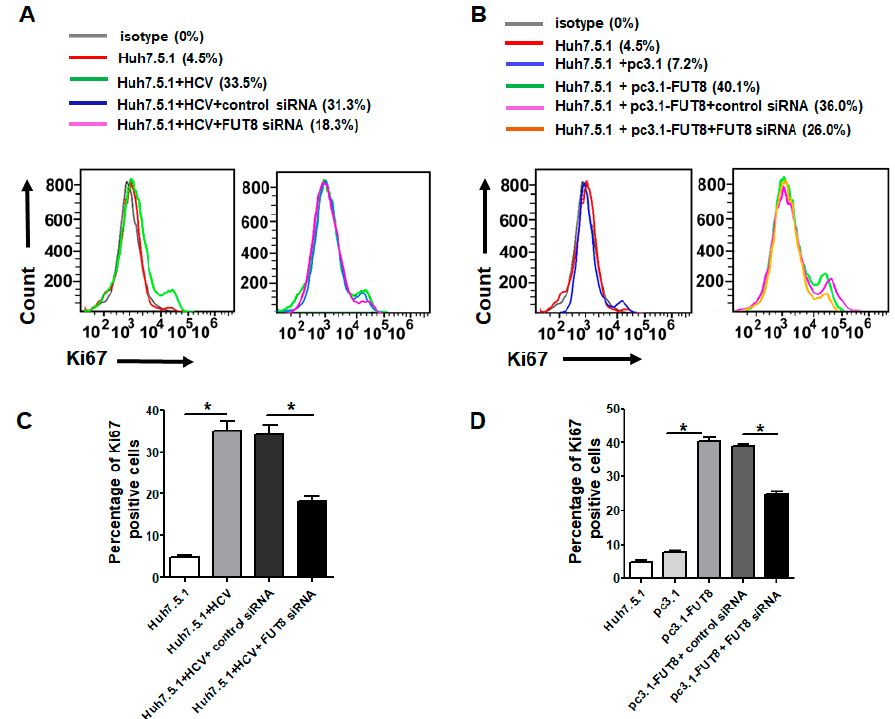
Figure 2. HCV infection and overexpression of FUT8 enhanced proliferation of Huh7.5.1 Cells. The expression levels of Ki67 were assessed by flow cytometry analysis (FCM). Huh7.5.1 cell proliferation can be observed after HCV infection for 72 h ( A ) or FUT8 overexpression ( B ), which could be inhibited by knockdown of FUT8. Statistical analyses of A and B are also listed as C and D .